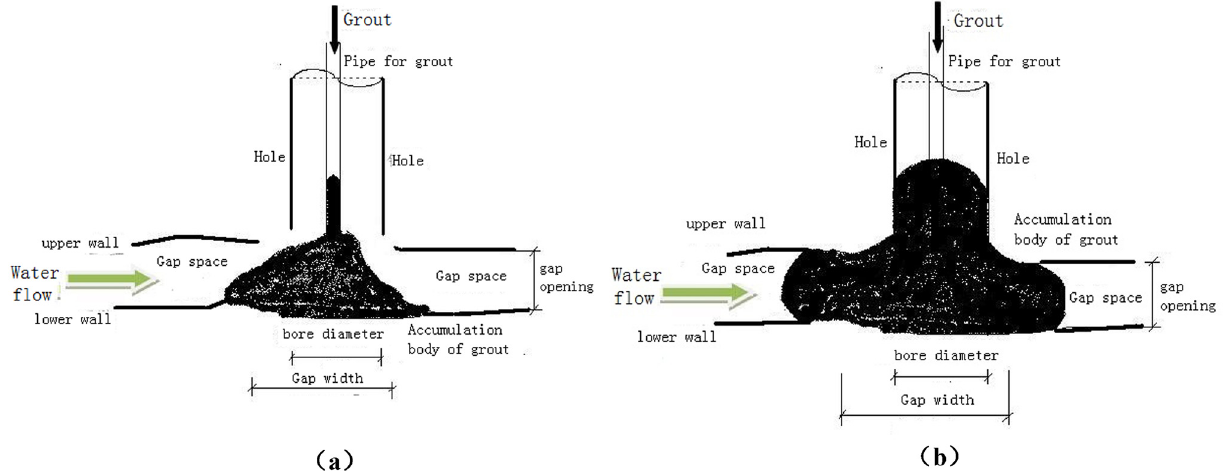
Figure 13: Diffusion method of the slurry in wide pores: ( a ) free diffusion period and ( b ) pore diffusion